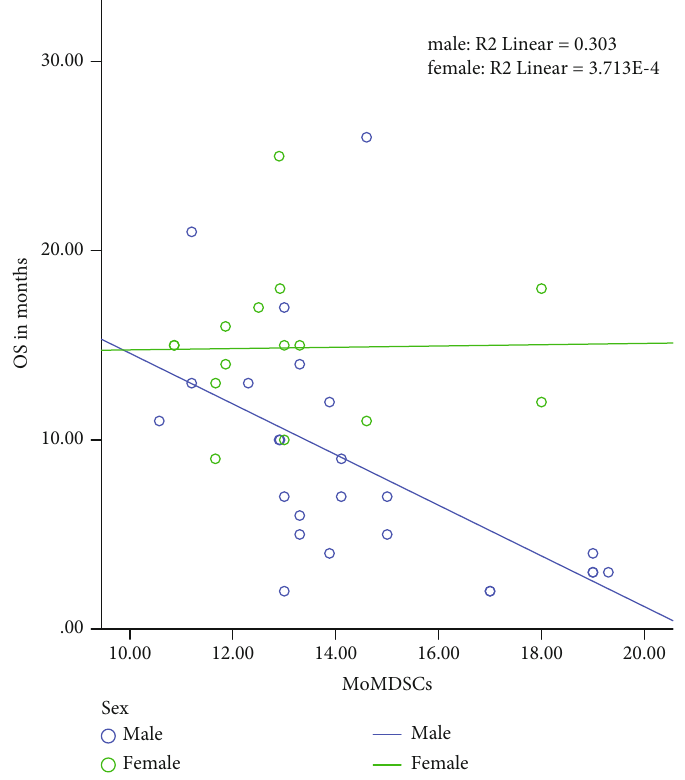
Figure 2: Correlation between overall survival (OS) and myeloid-derived suppressor cells (MDSCs) according to